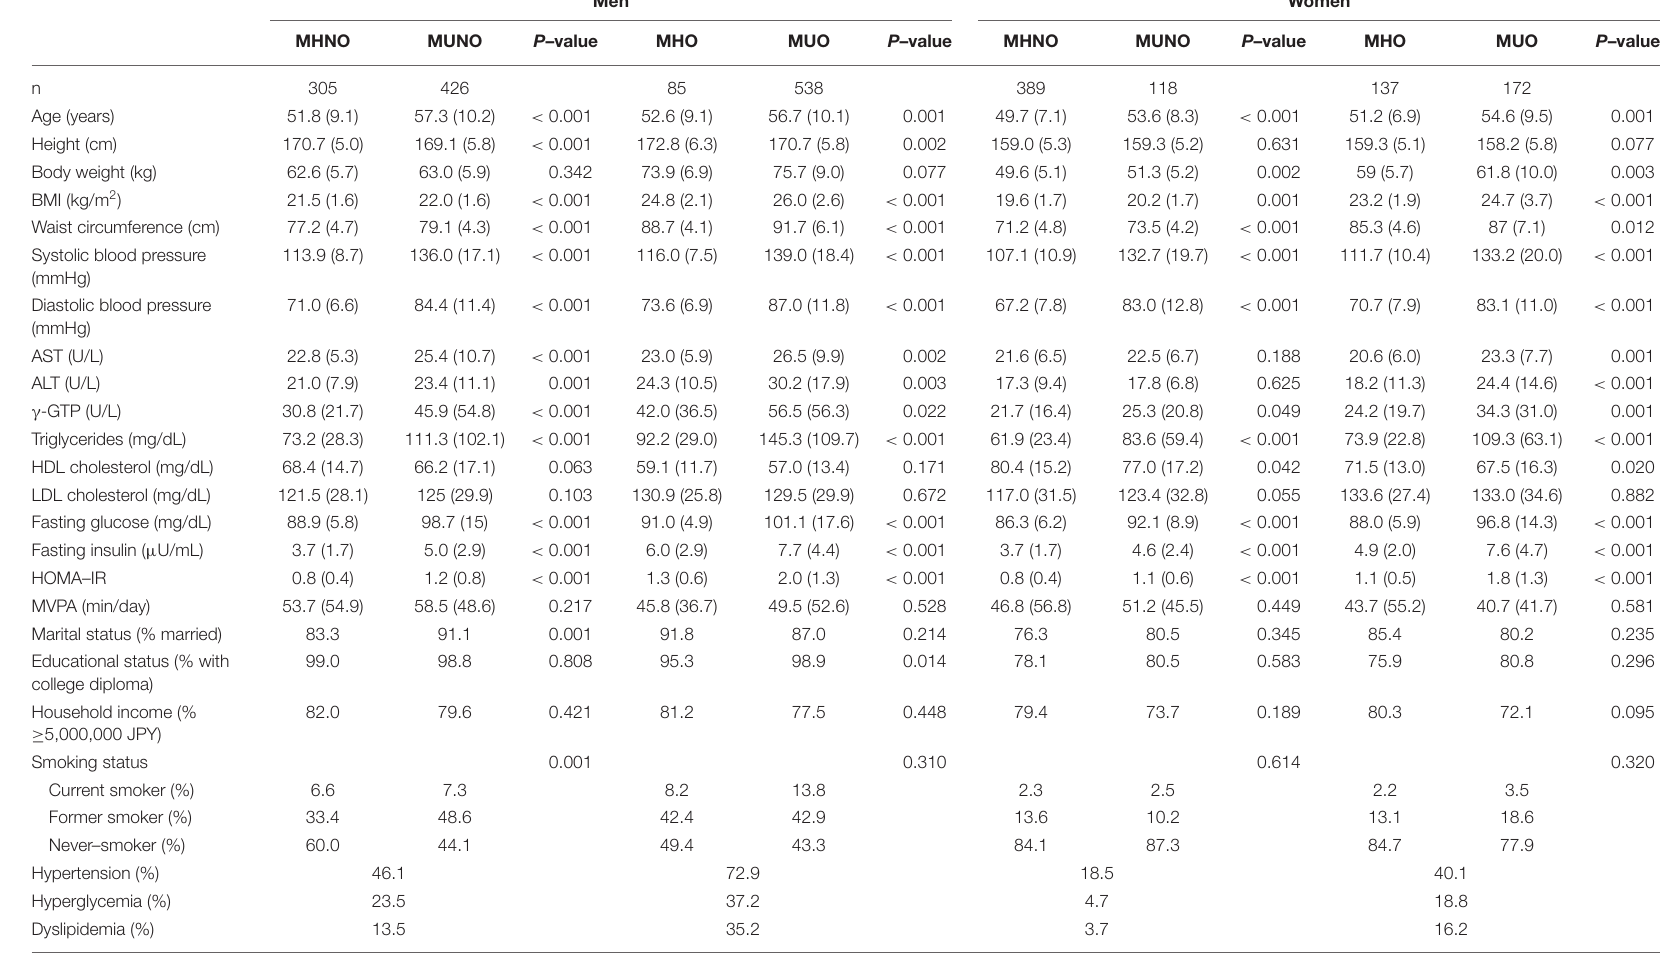
TABLE 2 | Participants’ characteristics according to metabolic phenotype in men vs.